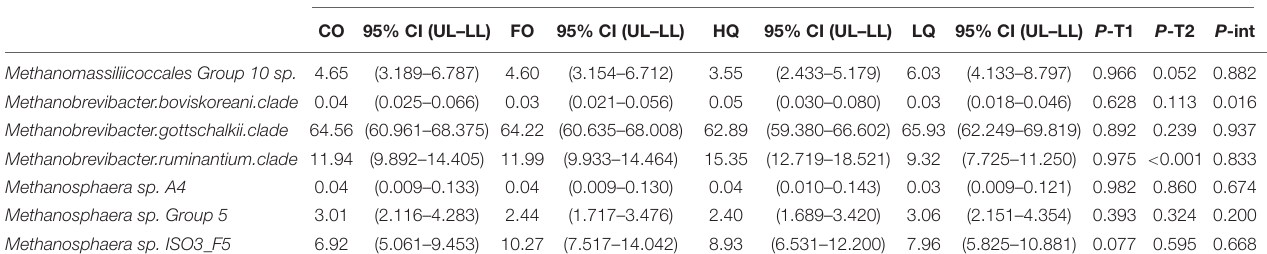
Methanomassiliicoccales Group 10 sp.